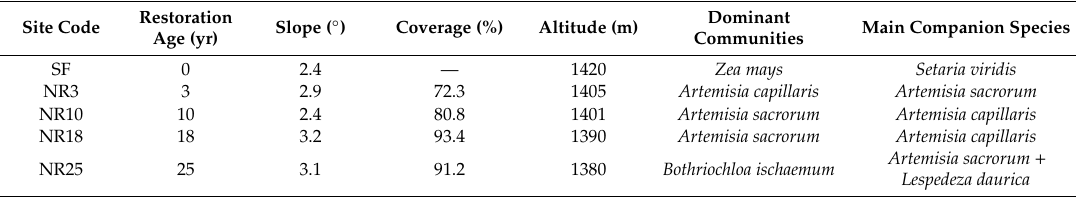
Table 1. Basic information of the selected five sampling